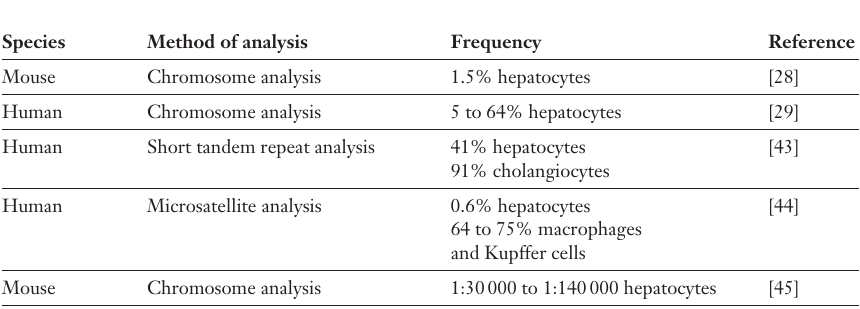
Table 1 Observed frequen- cies of transdifferen- tiated hepatocytes with extrahepatic